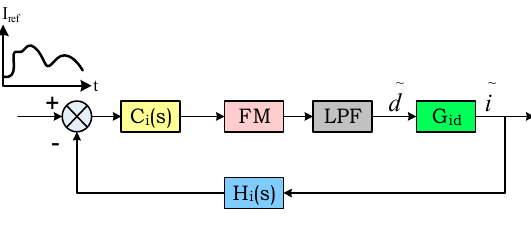
Figure 7. Current control loop.